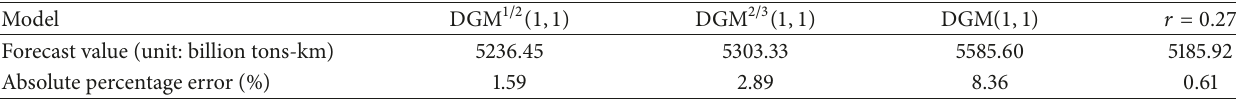
Table 4: The forecast values and errors of different discrete grey models (year 2009).